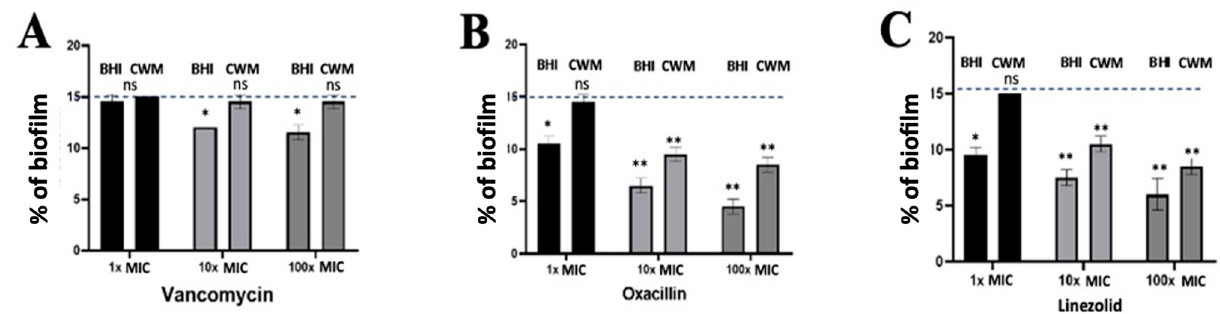
Figure 6. Percentage of biofilm reduction on preformed Staphylococcus aureus Newman biofilm in the BioFlux TM system using vancomycin ( A ), oxacillin ( B ) and linezolid ( C ) at different concentrations (1x, 10x and 100x MIC) and in the CWM and BHI media. An automatized debridement was fixed at 15% of biofilm left in the microfluidic channel. Samples were tested in three independent experiments. Results are presented as the mean ± standard deviation. Statistics were performed using a t-test on GraphPad Prism version 7. Ns, p > 0.05; * p < 0.1; ** p < 0.01.